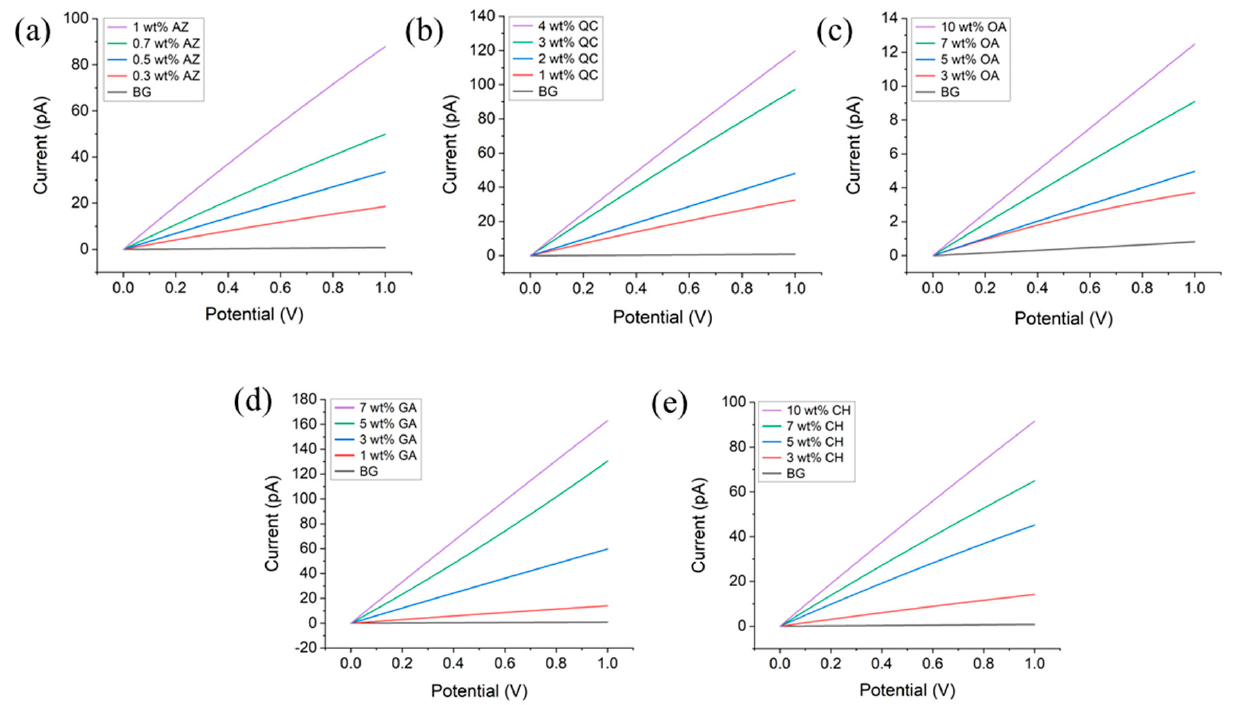
Figure 4. Effect of wt% and type of additives introduced into PCL on current at 200 °C. ( a ) AZ, ( b ) QC, ( c ) OA, ( d ) GA, ( e ) CH.